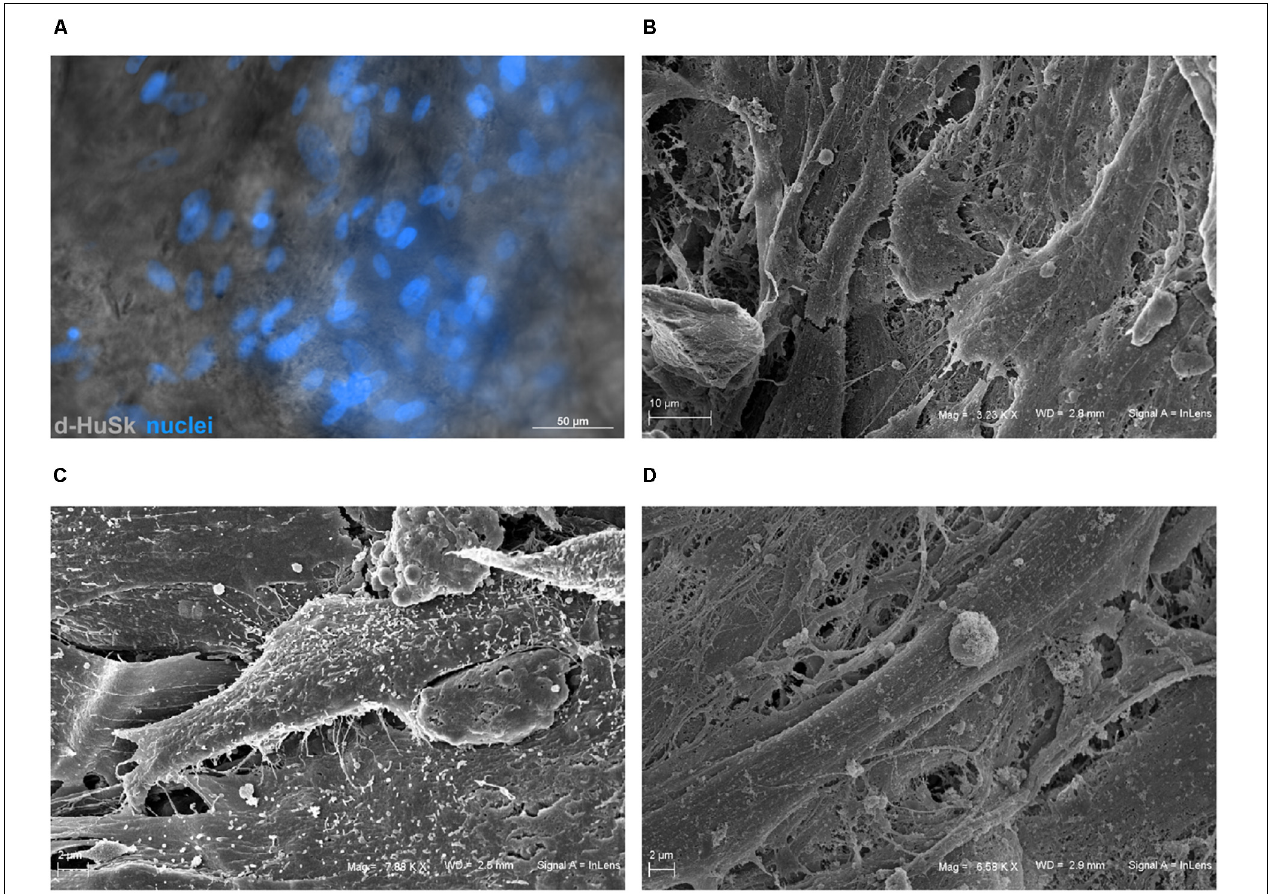
FIGURE 7 | Microscopic analysis of hCPCs engraftment on d-HuSk. (A) Representative image of fluorescence and phase contrast microscope analysis showing by the nuclear staining with DAPI the presence of hCPCs engrafted onto d-HuSk. Representative images of SEM analysis showing two hCPCs that contact each other (B) , one cell with elongated irregular shape characterized by multiple filopodia (C) and a cell with an elongated rectangular shape (D) . [Scale bar: 50 µ m for (A) , 10 µ m for (B) , and 2 µ m for (C,D)